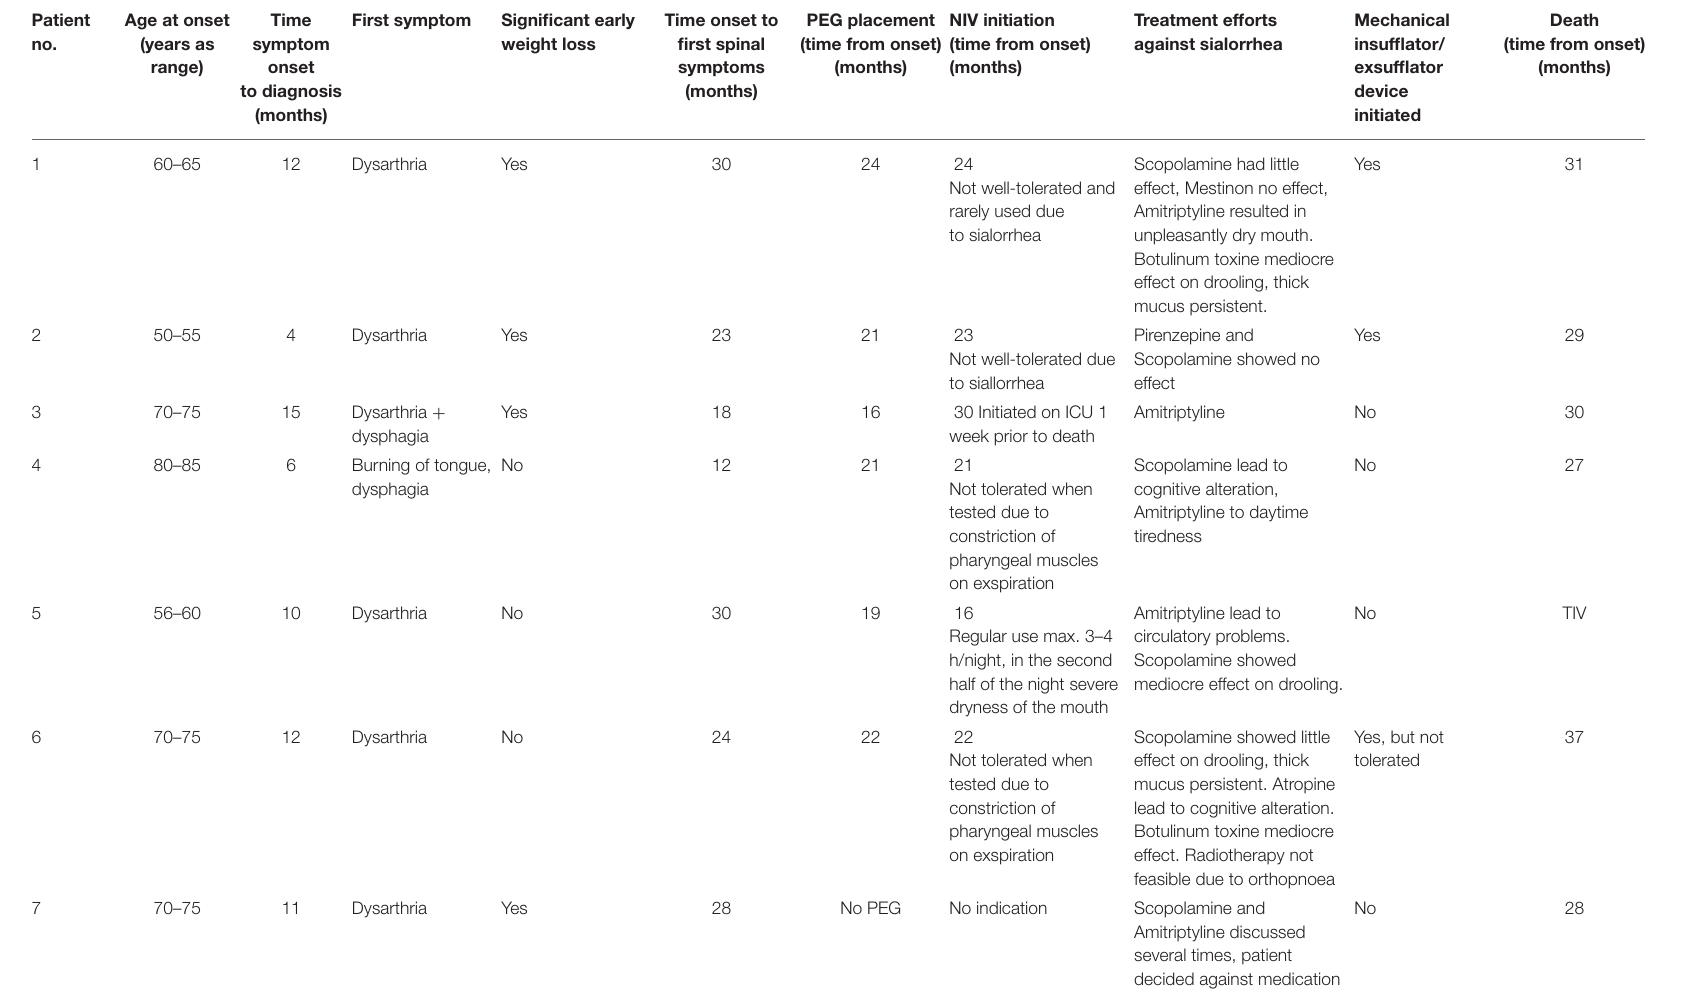
TABLE 1A | Demographic and clinical data of patients with progressive bulbar palsy. Patient